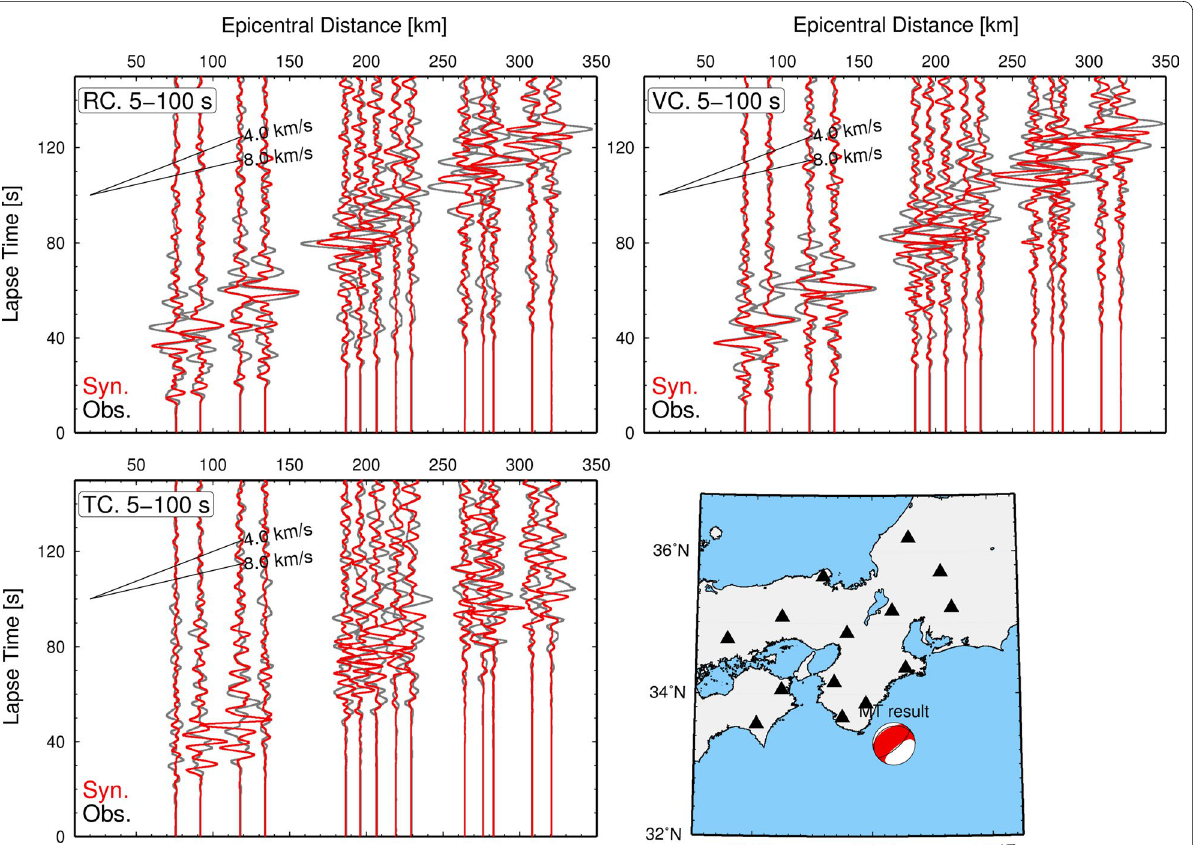
Fig. 12 Comparison of three-component velocity seismograms for periods of 5–100 s. Black and red traces are the observed and synthetic velocity waveforms at F-net stations,